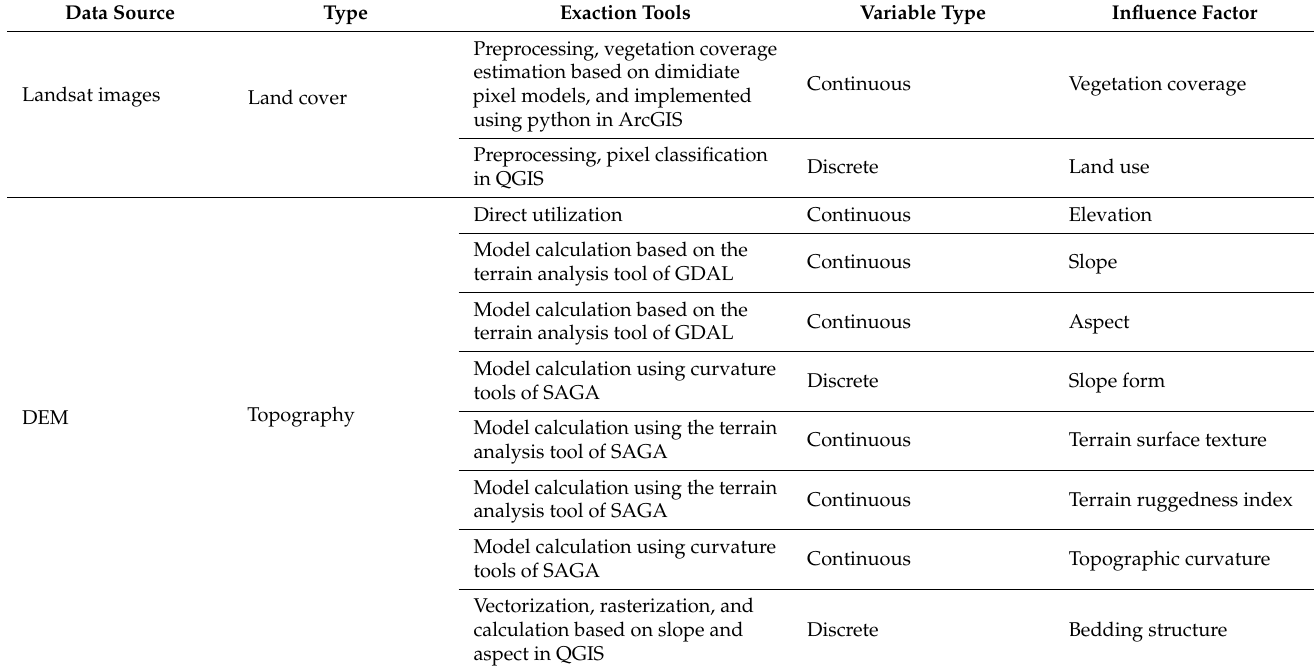
Table 1. Landslide influence factors, the exaction tools used, and their variable